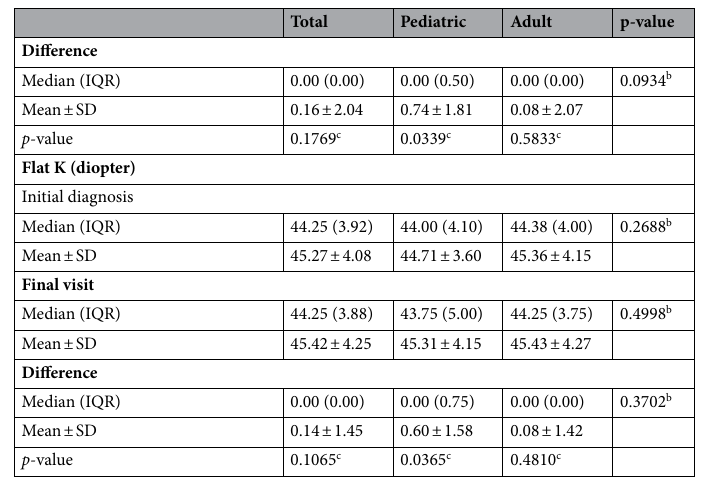
Table 2. Optical variables of patients with keratoconus at the initial diagnosis and the final visit before intervention. a from the initial diagnosis of KC to the final visit before intervention. b Wilcoxon rank-sum test. c Wilcoxon signed-rank test. K: keratometry readings. CDVA: corrected distance visual acuity. SD: standard deviation. *Statistical significance according to the sequential Bonferroni-type procedure, because the smallest p was < i/46* 0.05 for the 46 multiple tests in Tables 1 and 2, and i is the ranking of the p values of multiple tests from smallest to largest as